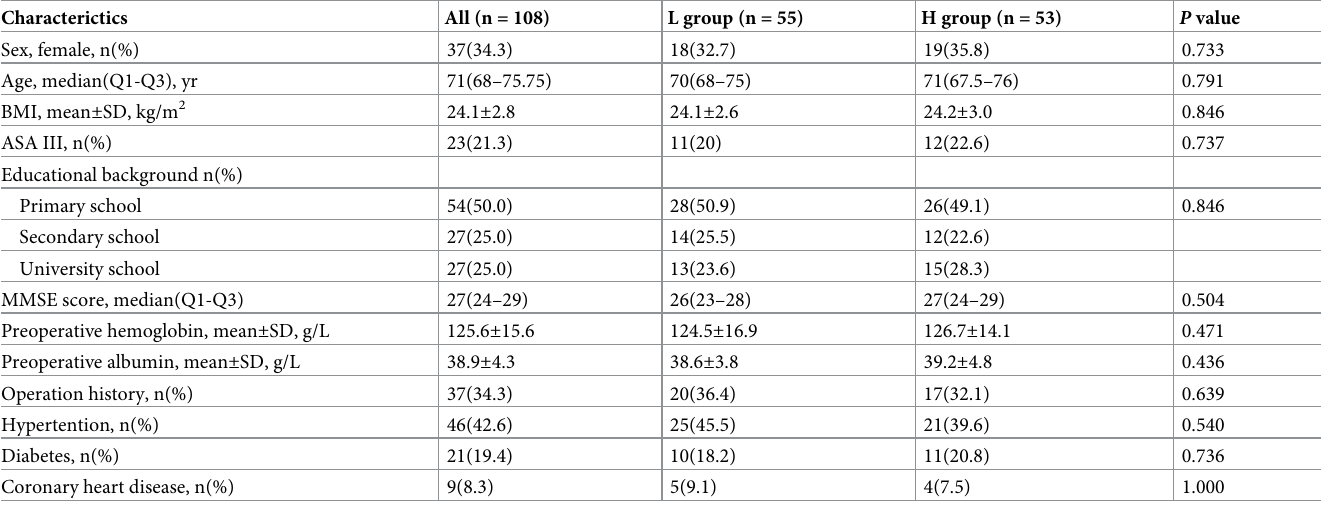
Table 1. Baseline characteristics of study participants by treatment